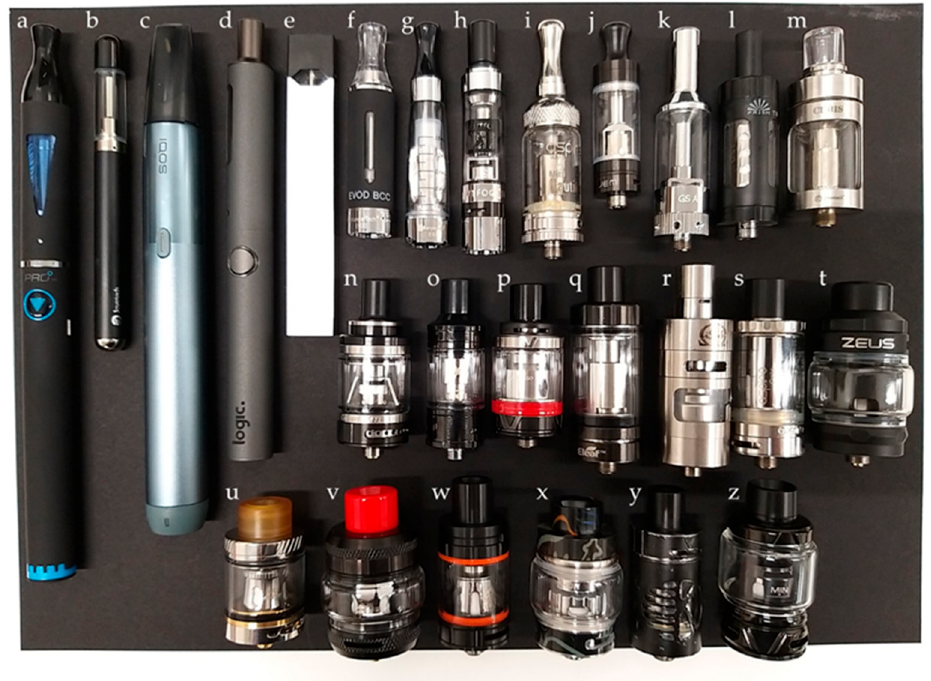
Figure 5. Photography of the twenty-six tested e-cigs ( a – e ) and atomisers ( f – z ).